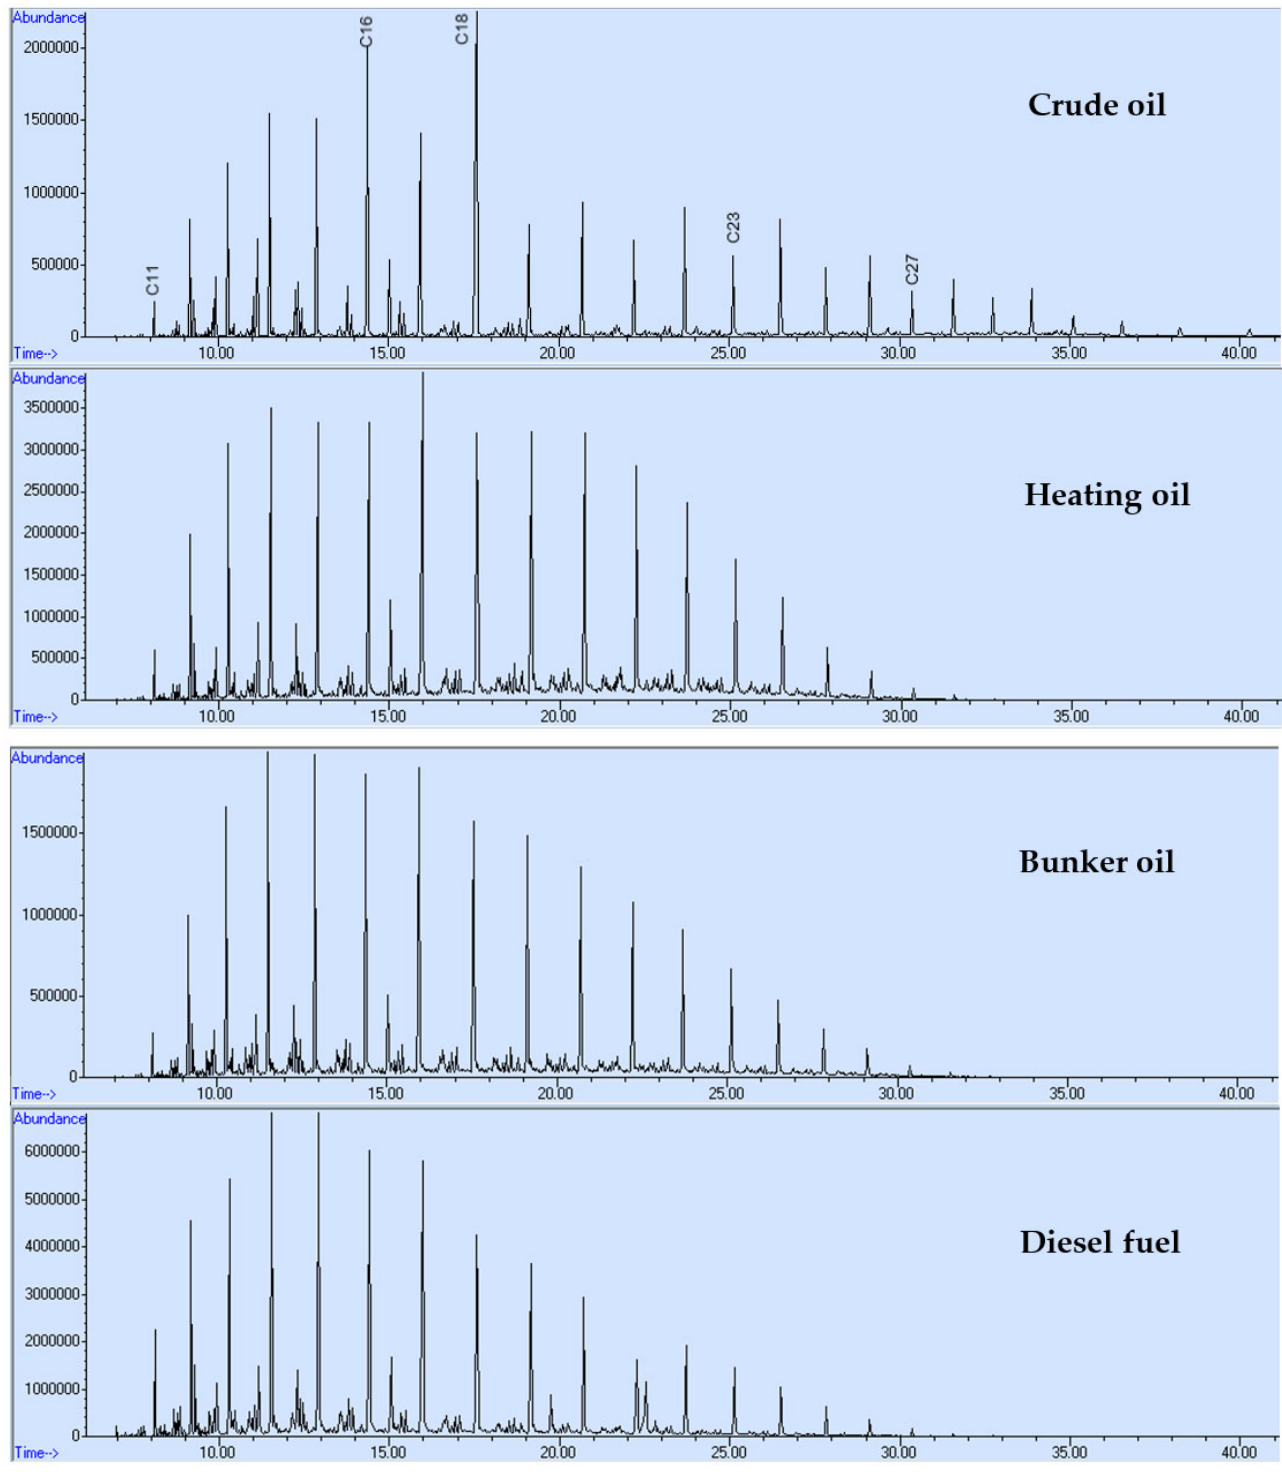
Figure 3. EIC comparison of m/z 57 between crude oil and diesel samples (heating oil, bunker oil, and diesel fuel).